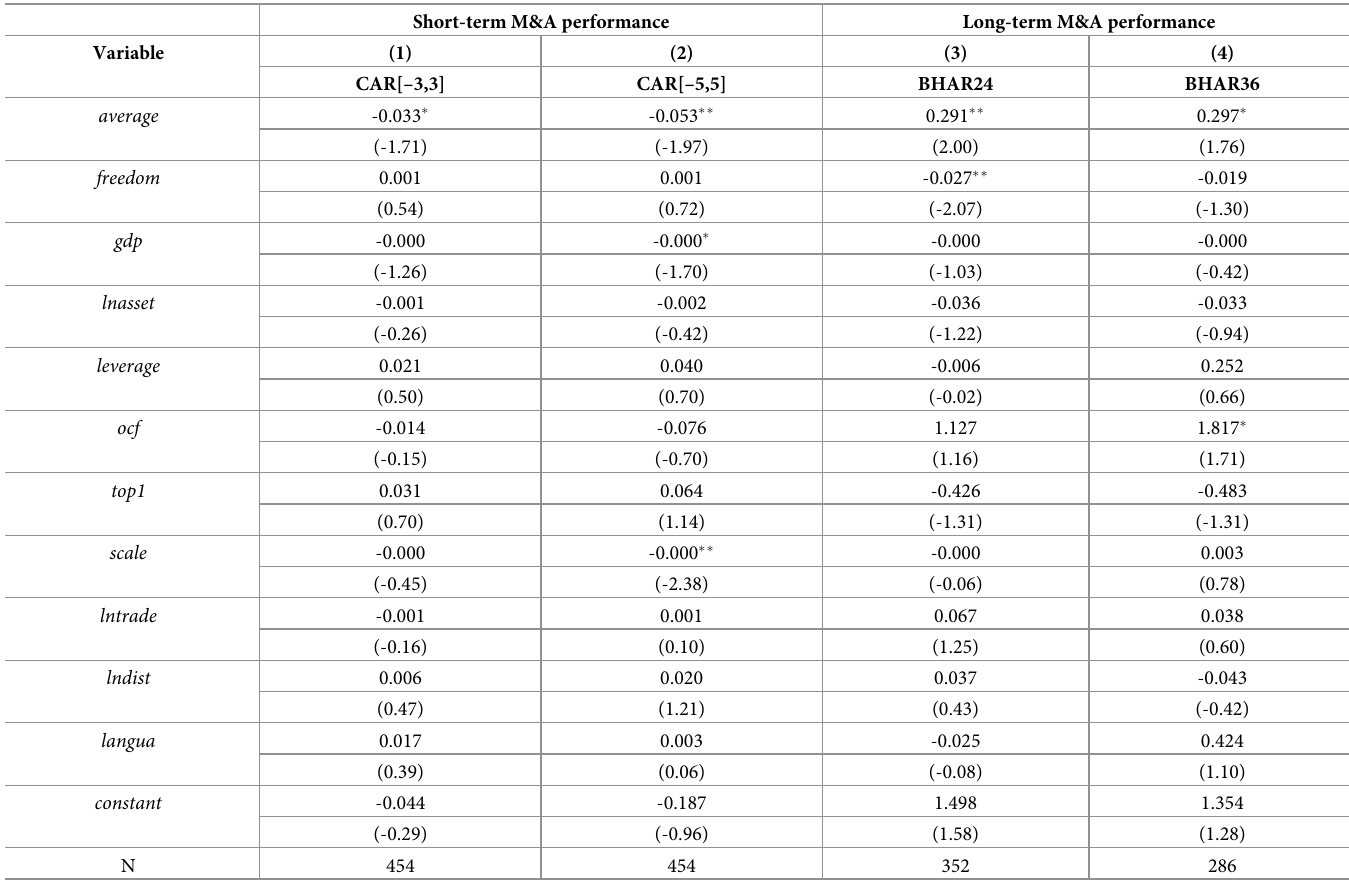
Table 2. Governmental governance capacity and short-term and long-term M&A